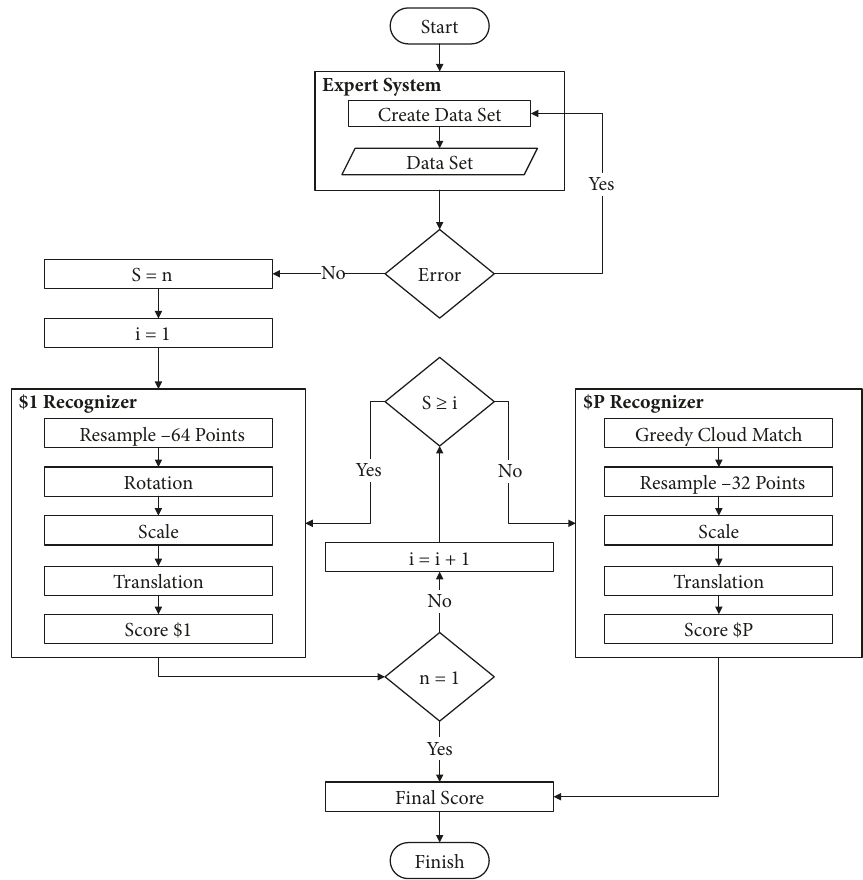
Figure 8: Expert Point Cloud Recognizer